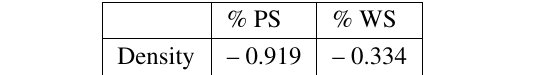
Table 7. Correlation table for bulk density of Bagasse based bricks